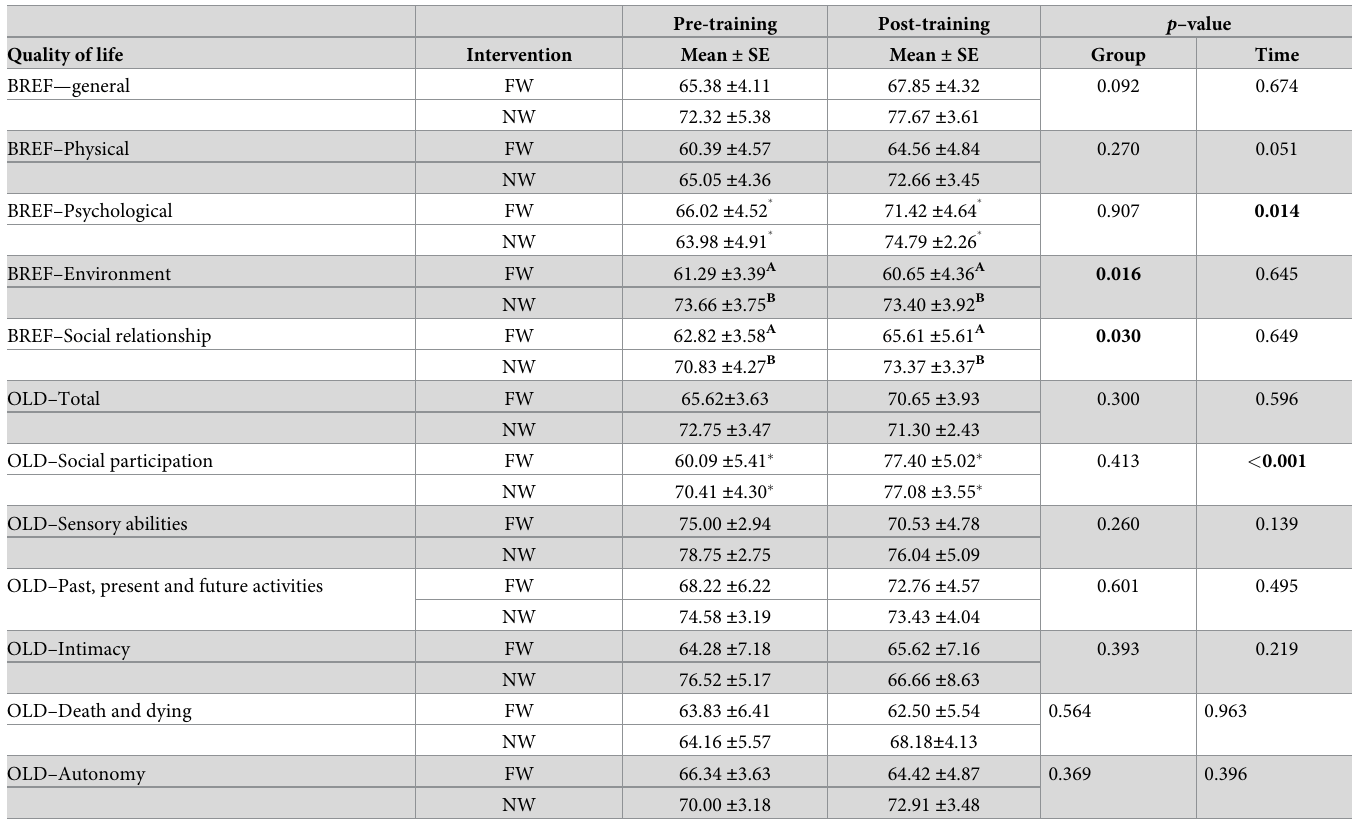
Table 2. Results from GEE model effects tests for quality of life test variables of WHOQOL-BREF and WHOQOL-OLD in the different domains. � Symbol repre- sents significant differences in time factor (pre and post-training), and different capital letters represent significant differences in group factor (FW and